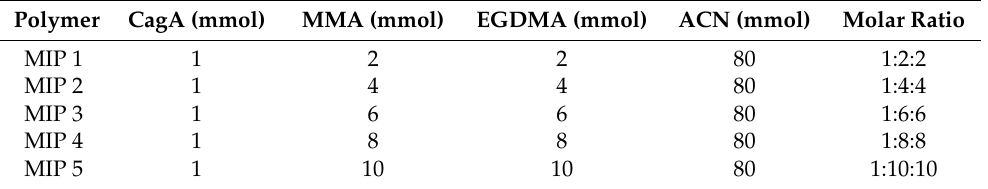
Table 1. Prepolymerization mixtures for the molecular simulation of MIP.